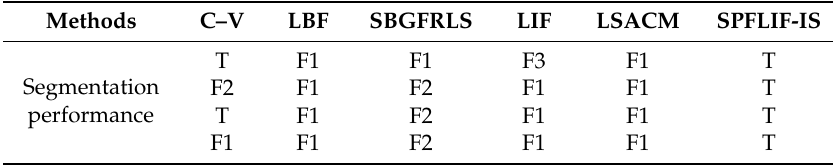
Table 5. Description of the segmentation results of Figure